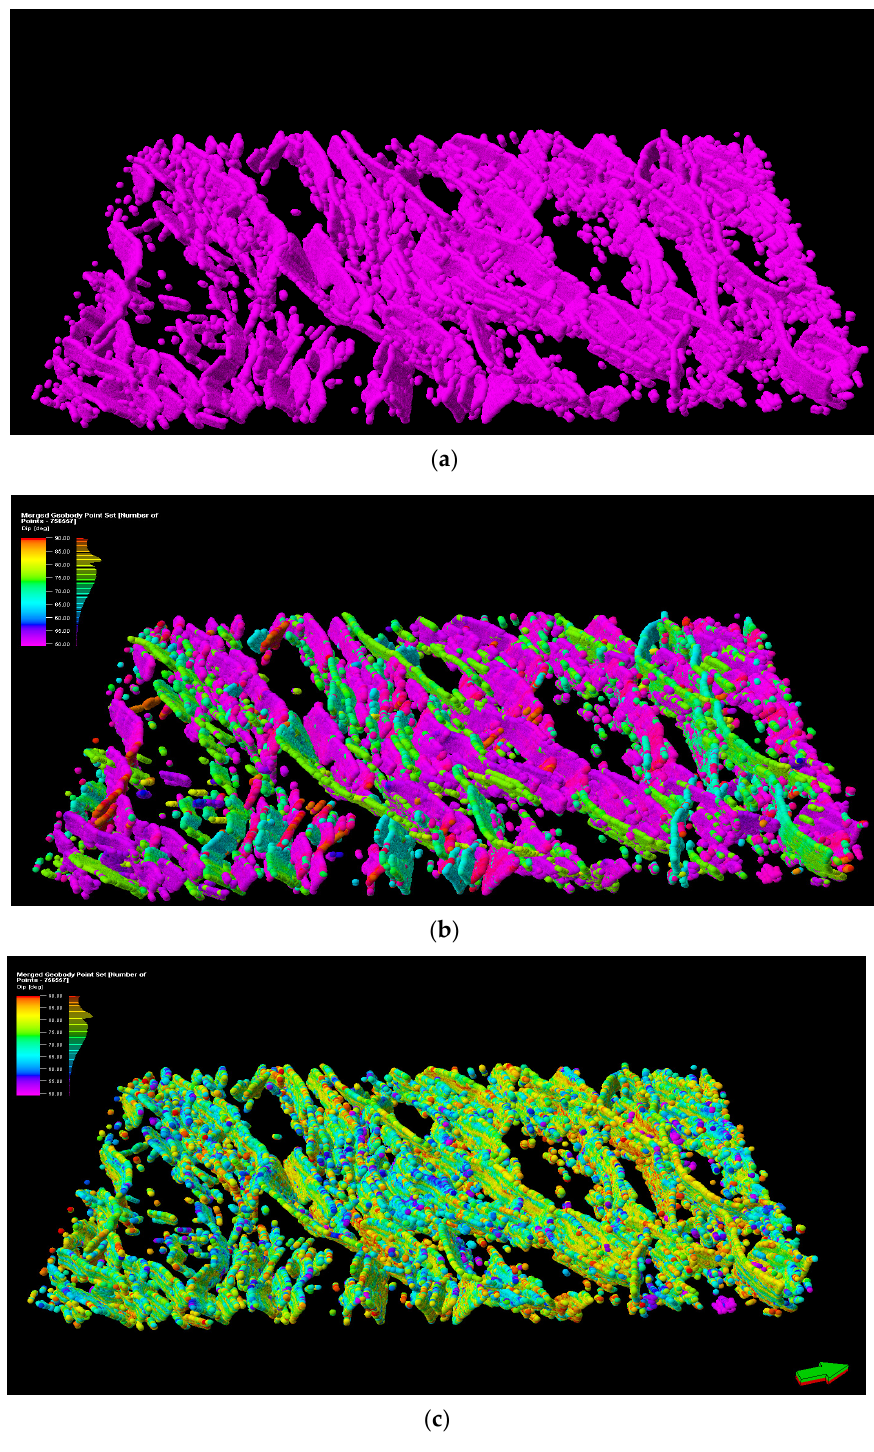
Figure 8. Extracted fault surfaces as ( a ) point type. To perform orientation clustering, ( b ) azimuth and ( c ) dip information for each point position was also extracted.